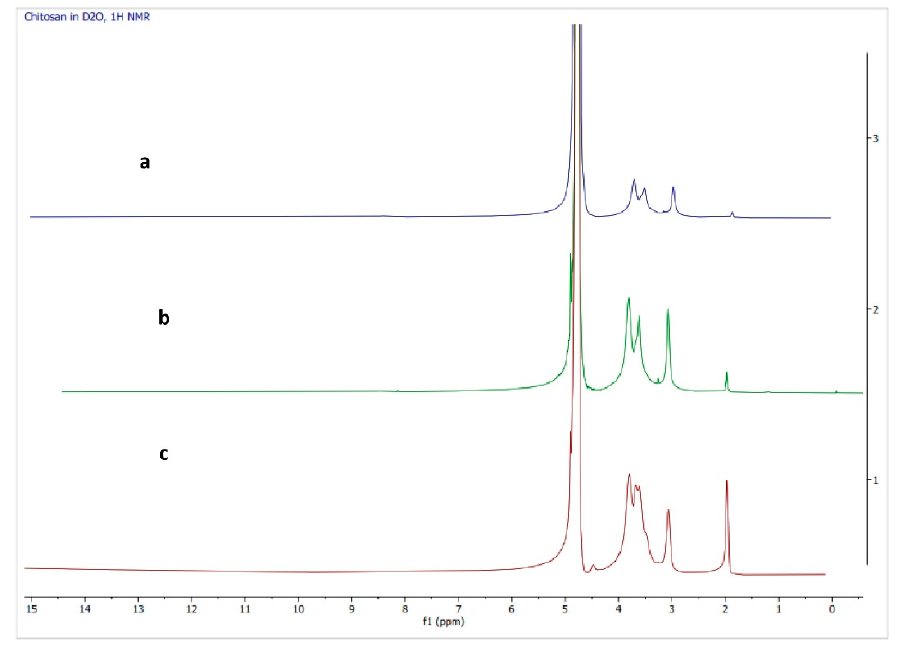
Figure 5. NMR spectrum of: (a) LMW chitosan, (b) native chitosan; (c) commercial